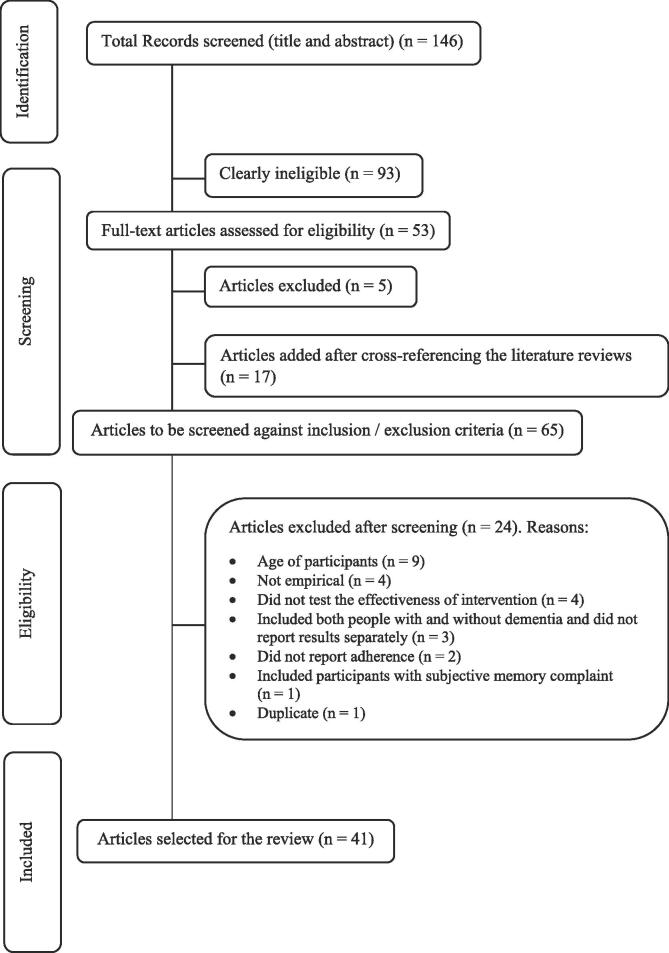
Selection of papers.